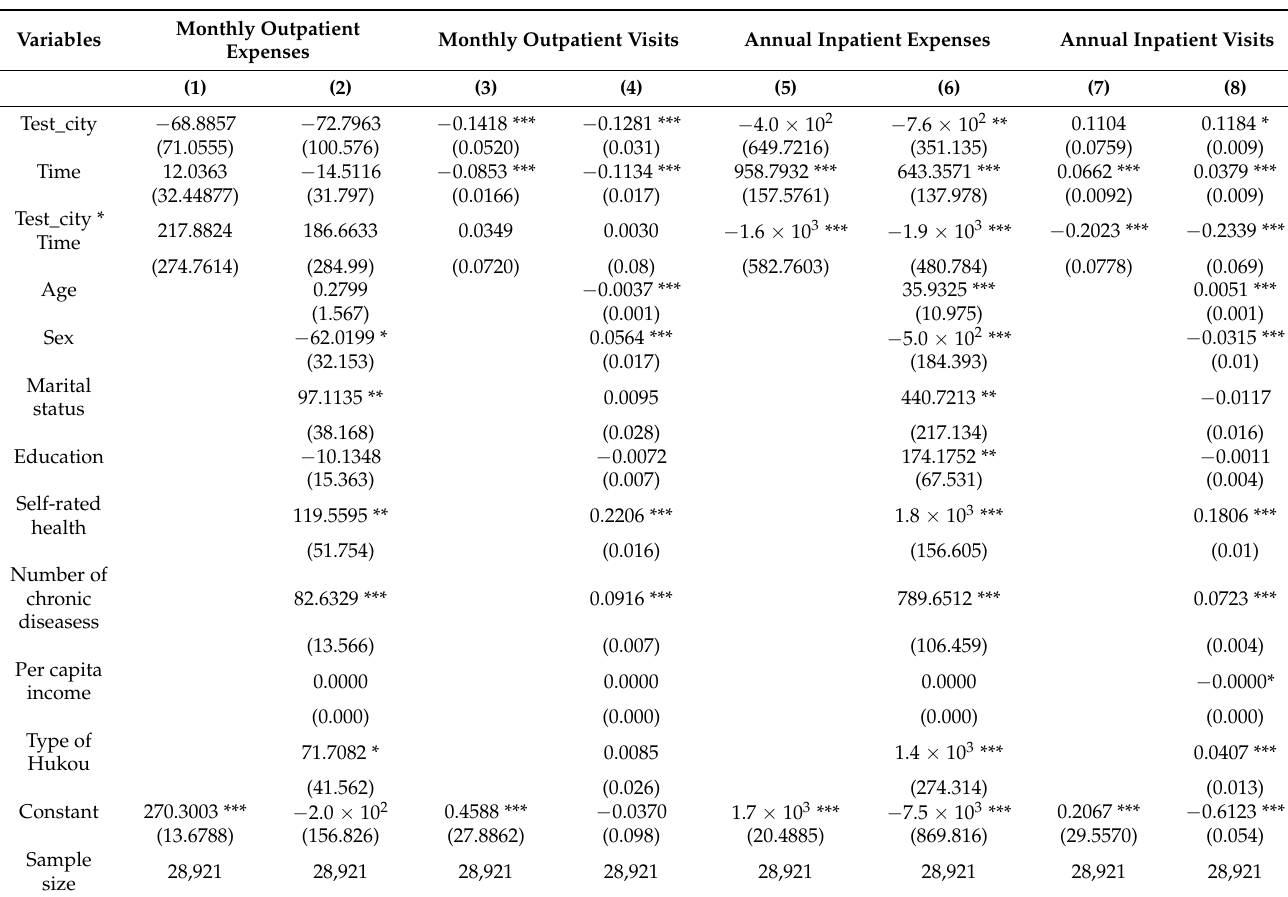
Table 4. DID results with matched